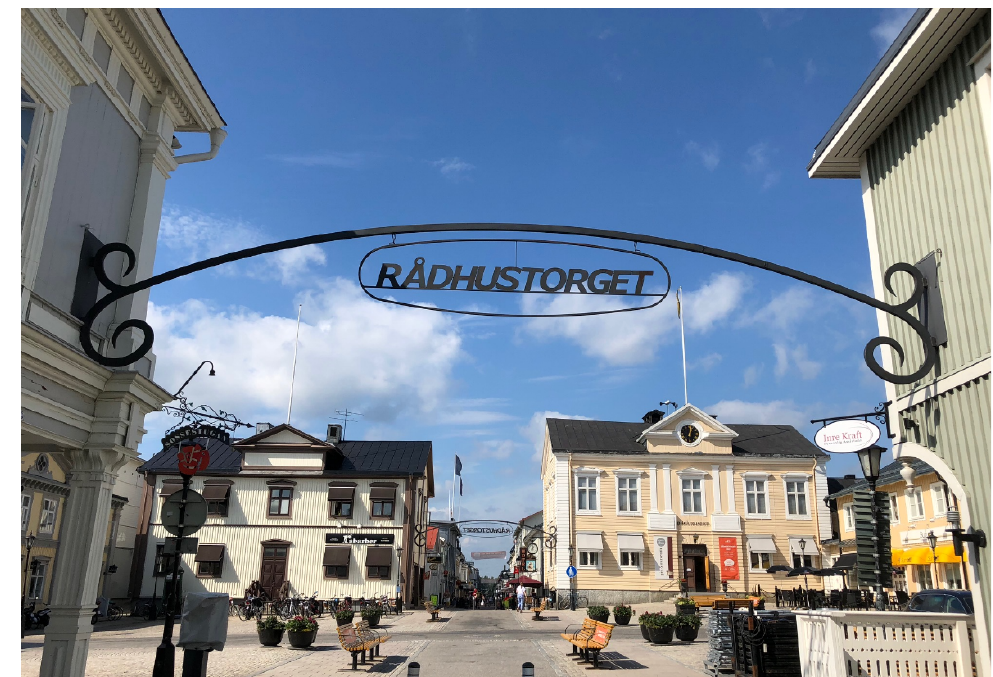
Figure 1. Piteå’s court-house square (photographer Johanna